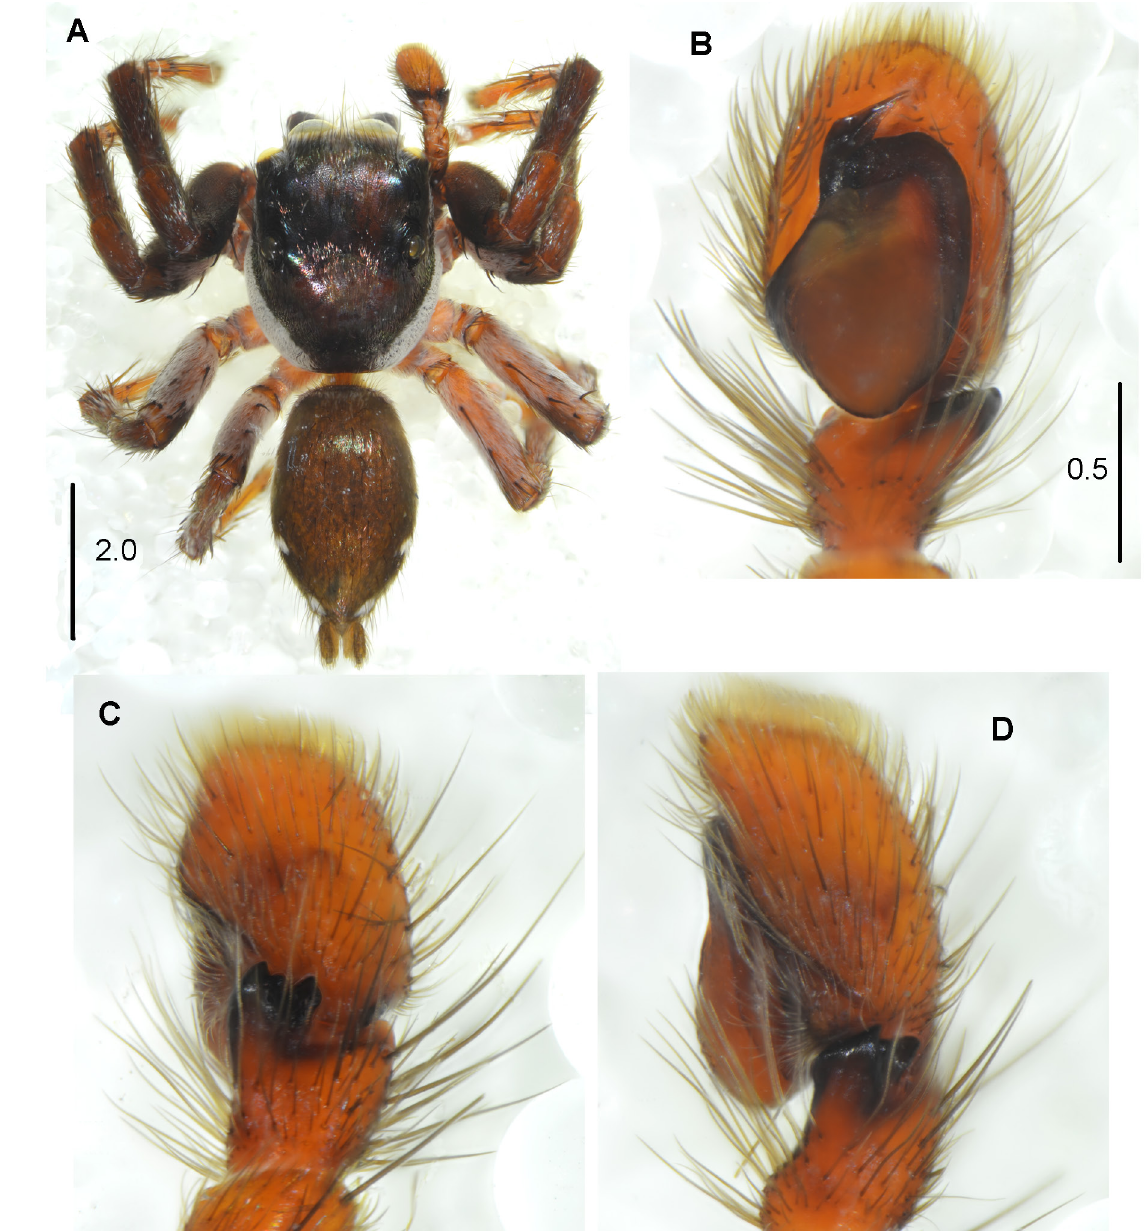
Fig. 13. Dasycyptus dimus Simon, 1902, ♂ (MNHN). A . Habitus, dorsal view. B . Palpal organ, ventral view. C . Palpal organ, dorsolateral view. D . Palpal organ, lateral